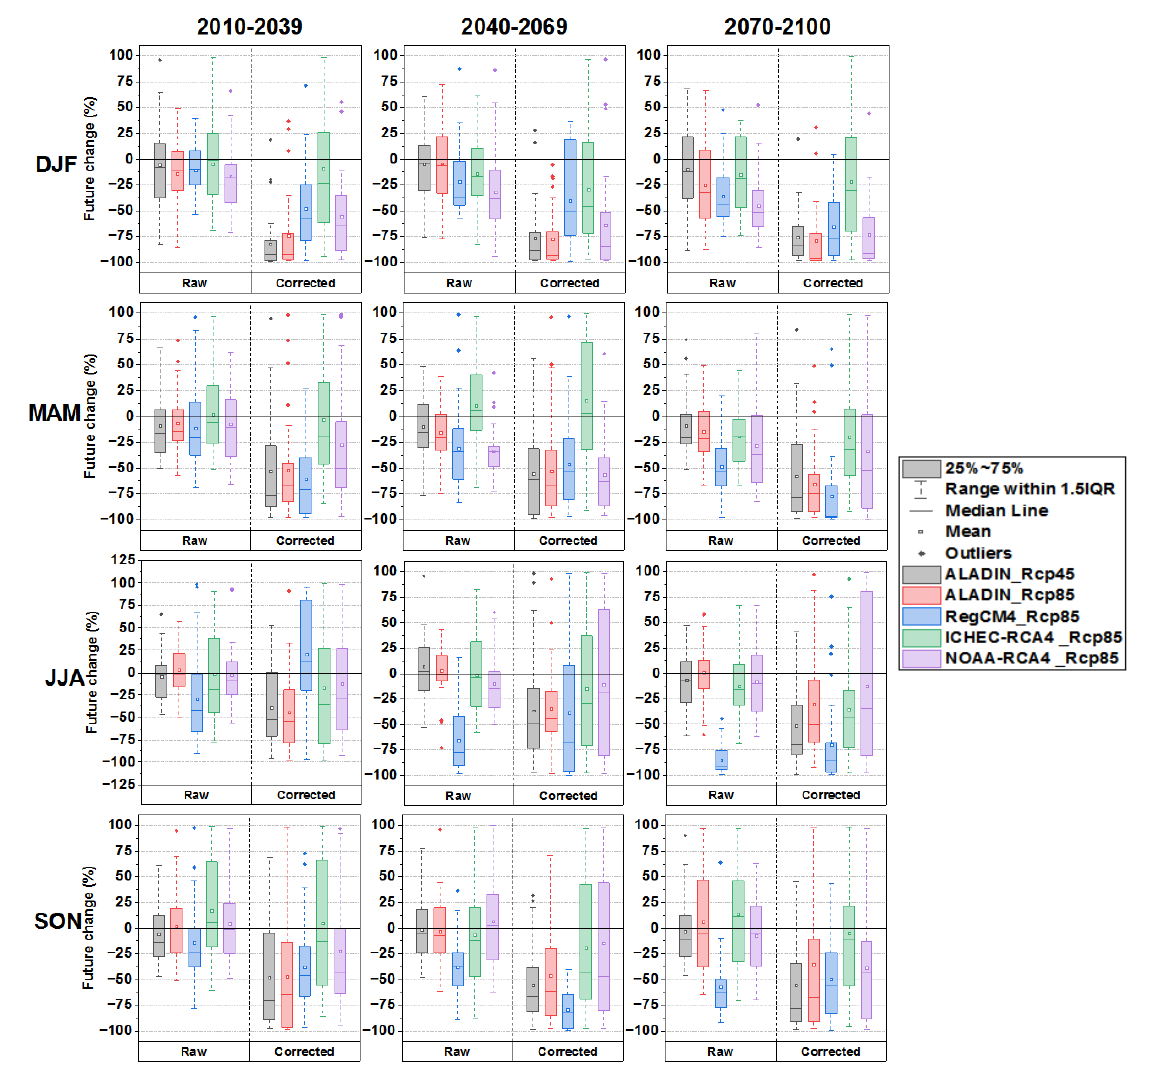
Figure 14. Future changes of seasonal average precipitation for 2010 – 2039, 2040 – 2069, and 2070 – 2100 (2070 – 2099 for ICTP-RegCM4- 3v1) with respect to 1970‒2005. Changes are in